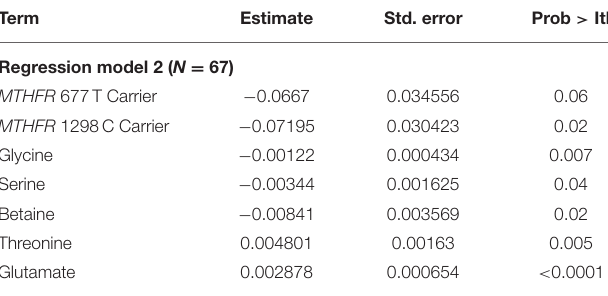
TABLE 3 | Final least squares regression model parameters.